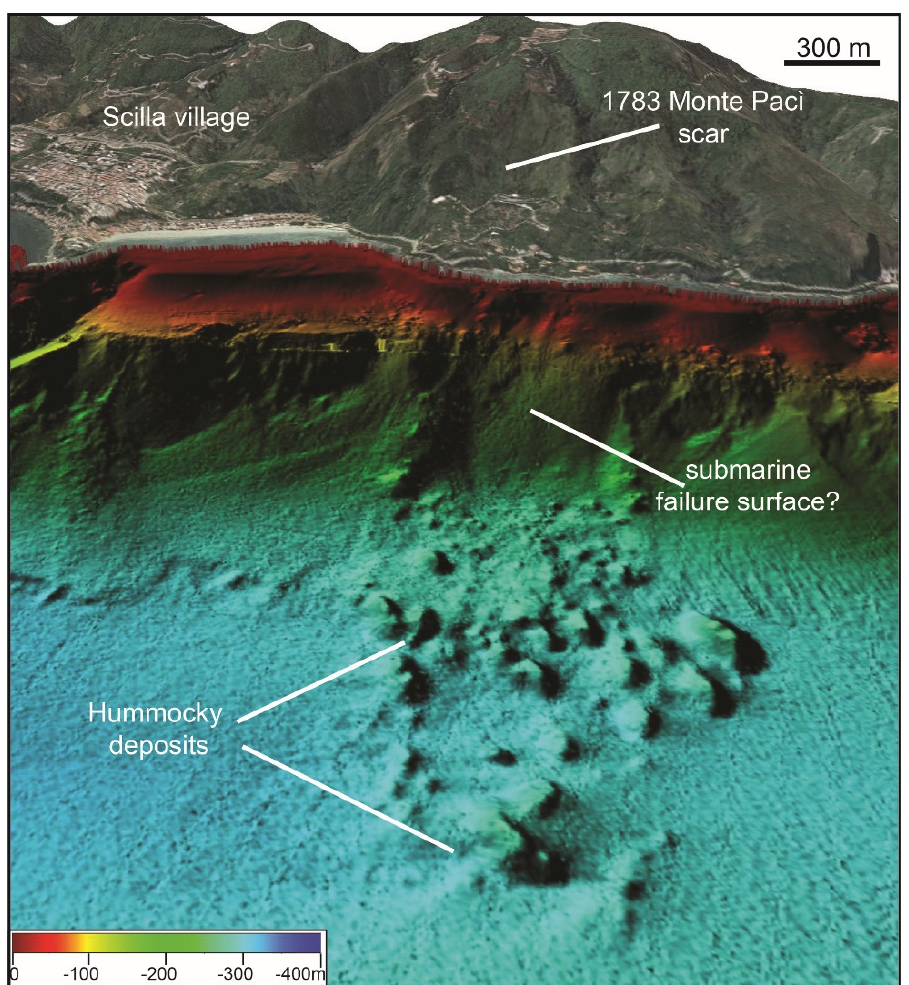
Figure 2. 3–D view of the hummocky deposits related to the 1783 Monte Pacì rocky and tsunamigenic landslide occurring off Scilla village, for location see Figure 1.